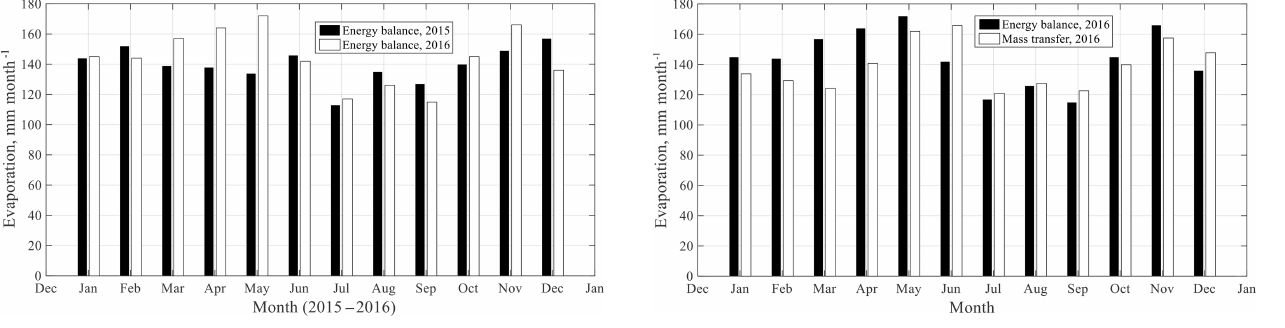
Figure 6. Monthly evaporation computed using energy balance ap- proach.